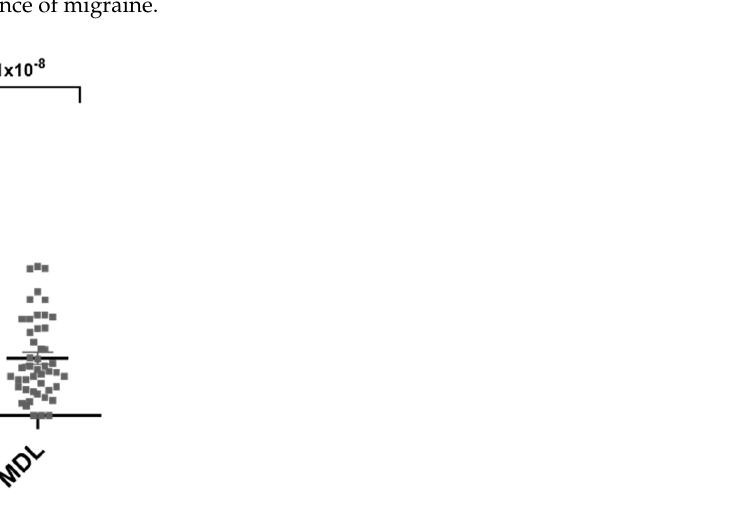
Figure 3. MD patients separated according to their IL-1 β levels (MDH (>4.78 pg/mL) and MDL (<4.78 pg/mL)).